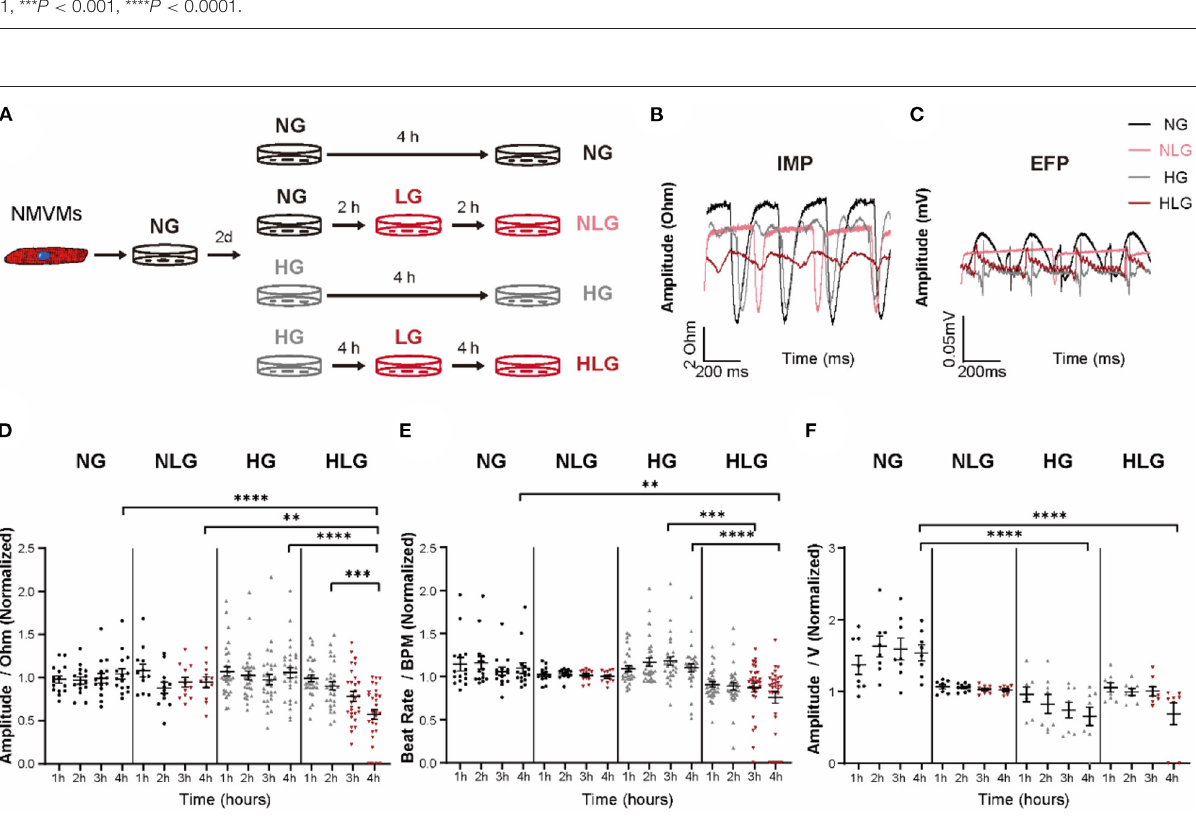
FIGURE 2 | whereas control mice were injected with sodium citrate buffer via intraperitoneally injection (ip). DM mice were diagnosed with DCM via echocardiography (DCM group) at week 8. DM mice were injected with insulin (100 IU) to induce severe hypoglycemia (HDCM group) at week 10 and then sacrificed. (B) M model and tissue Doppler flow in control, DCM, and HDCM mice at week 10. (C) Echocardiography analysis of ejection fraction (EF), fractional shortening (FS), and early to late ventricular filling velocity (E/A) and early mitral inflow velocity to early diastolic mitral annulus velocity (E/E’) ratios in the control ( n = 10 mice) and DCM ( n = 20 mice) group at both the weeks 2 and 8 post-STZ injection. (D) Presence of systolic and diastolic dysfunction of 10-week HDCM compared to DCM ( n = 10 mice for per group) evaluated by echocardiography. (E) Representative surface ECGs of control (black, n = 5 mice), DCM (gray, n = 8 mice), and HDCM (red, n = 8 mice) at week